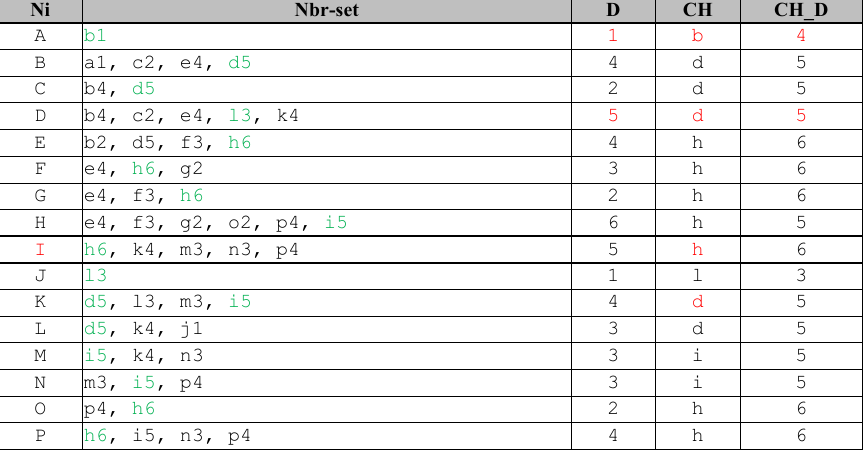
Table 1. Selected Cluster heads (candidate cluster head Nodes and their